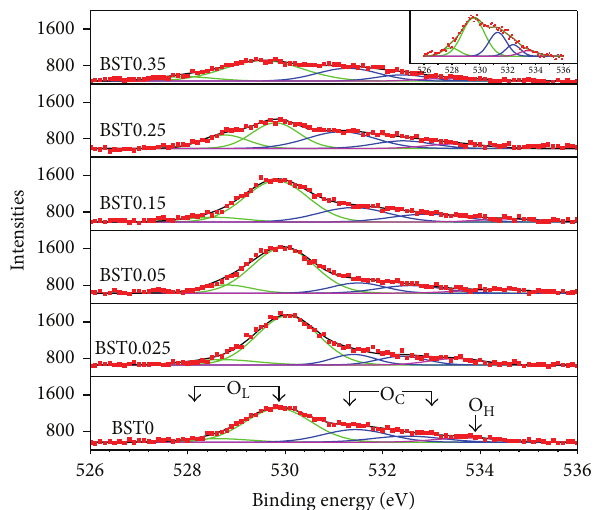
Figure 6: The fitting XPS spectra of O 1s deconvolution with Gaussian